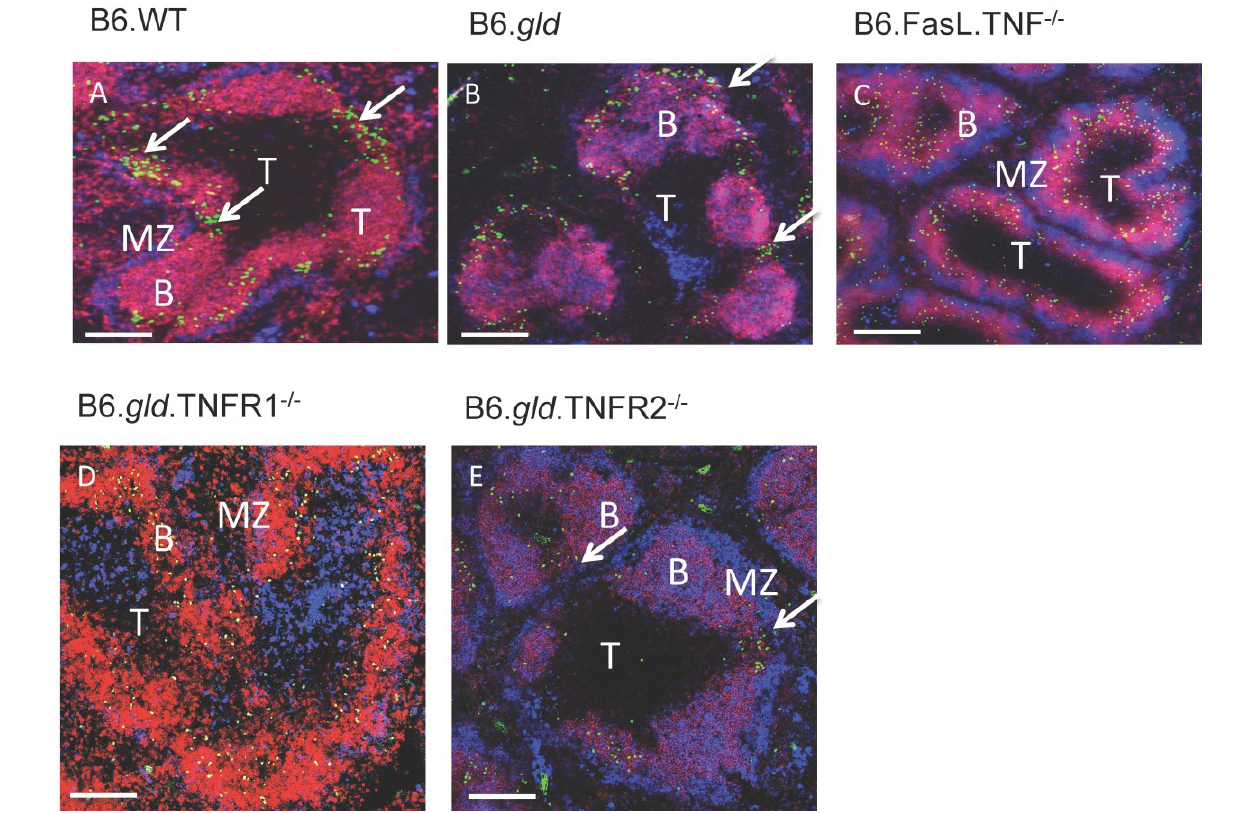
Figure 2. The spleen phenotype is determined by TNF-TNFR signaling. B6.WT ( A ), B6. gld ( B ), B6. gld .TNF −/− ( C ), B6. gld .TNFR1 −/− ( D ) and B6. gld .TNFR2 −/− ( E ) spleens were analyzed histologically after transfer of CFSE-labeled DN T cells. Using mAbs for IgM (red) and IgD (blue) the outline of the T cell area (T), B cell follicles (F) and the marginal zone (MZ) were determined. The bridging channels (arrows) are clearly visible in B6.WT, B6. gld , and B6. gld .TNFR2 −/− spleens (10× objective magnification). The scale bar equates to 250